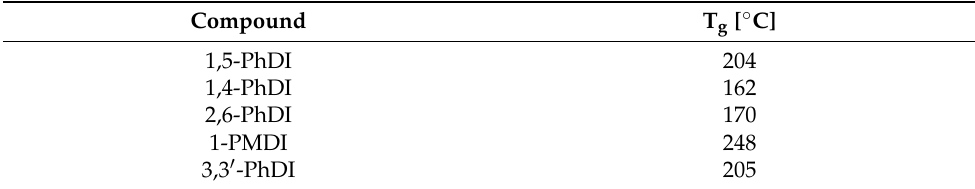
Table 2. Thermal parameters of studied